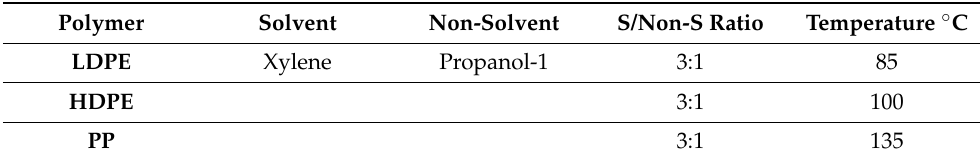
Table 1. Selected solvent, non-solvent and dissolution temperature for the separation of polyolefin mixtures